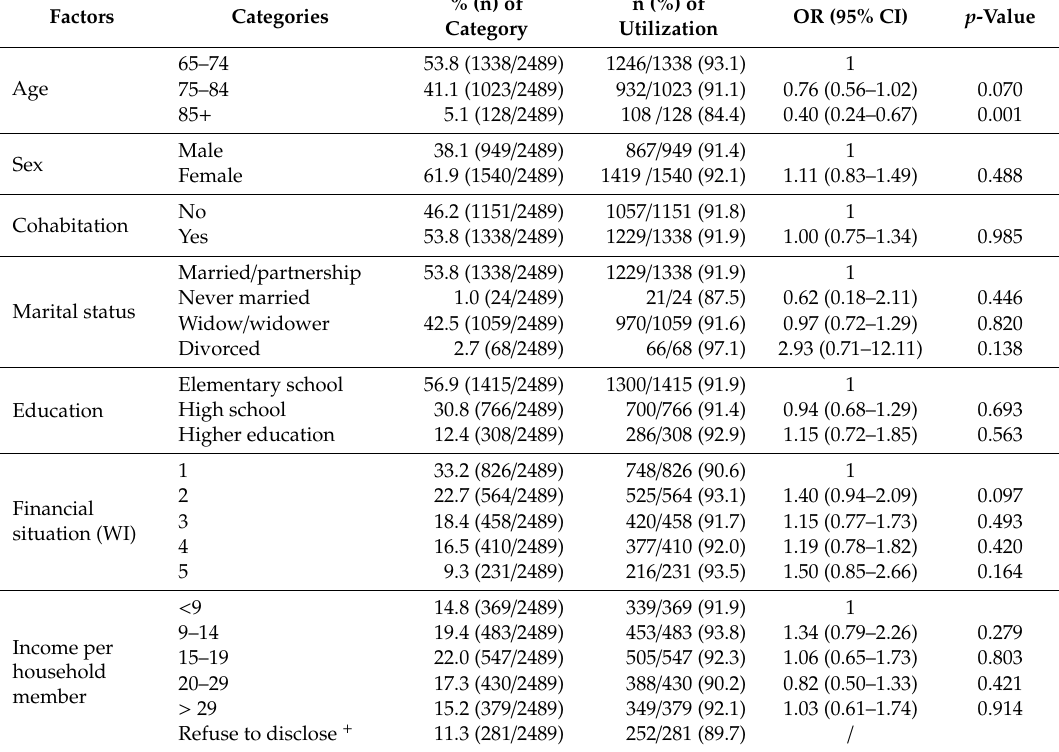
Table 1. Univariable analysis of the utilization of primary healthcare services by elderly CVD patients in the Republic of